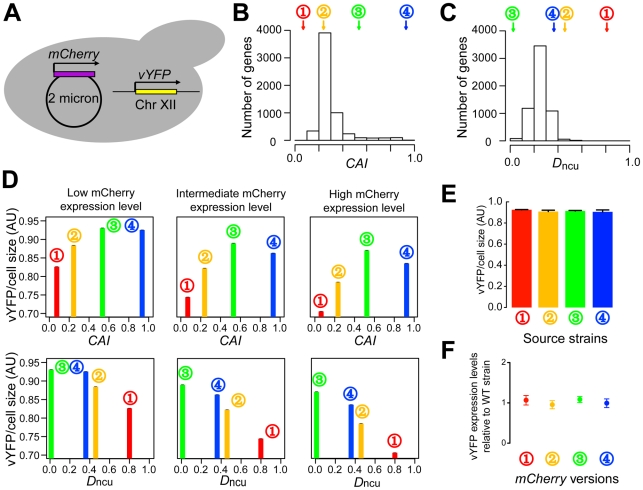
Experimental evidence for the impact of codon usage imbalance on translational efficiency.(A) Experimental design for examining the impact of mCherry expression on the expression of the reporter vYFP. An mCherry gene is constitutively expressed from a 2-micron plasmid in S. cerevisiae, whereas vYFP is constitutively expressed from Chromosome XII. Four different synonymous versions of mCherry are compared. (B) The codon adaptation indices (CAIs) of the four synonymous mCherry sequences (circled numbers), in comparison to CAIs of all S. cerevisiae genes. (C) Values of distance to native codon usage of yeast (D
ncu) for the four mCherry sequences, in comparison to that of all S. cerevisiae genes. (D) Relationship between vYFP expression and the CAI or D
ncu of mCherry, when the mCherry expression is controlled for. A finer control of mCherry expression is presented in Figure S6, where cells of the low, intermediate, and high mCherry expressions defined here are each subdivided into 5 bins. Error bars, which are barely seen, show one standard error. (E) vYFP expressions in the four strains after the removal of the plasmids that carry mCherry. Error bars show one standard error. (F) vYFP mRNA levels of the four strains relative to that of the wild-type strain, which does not carry mCherry. The mean expressions from three biological replications and the standard errors are presented.